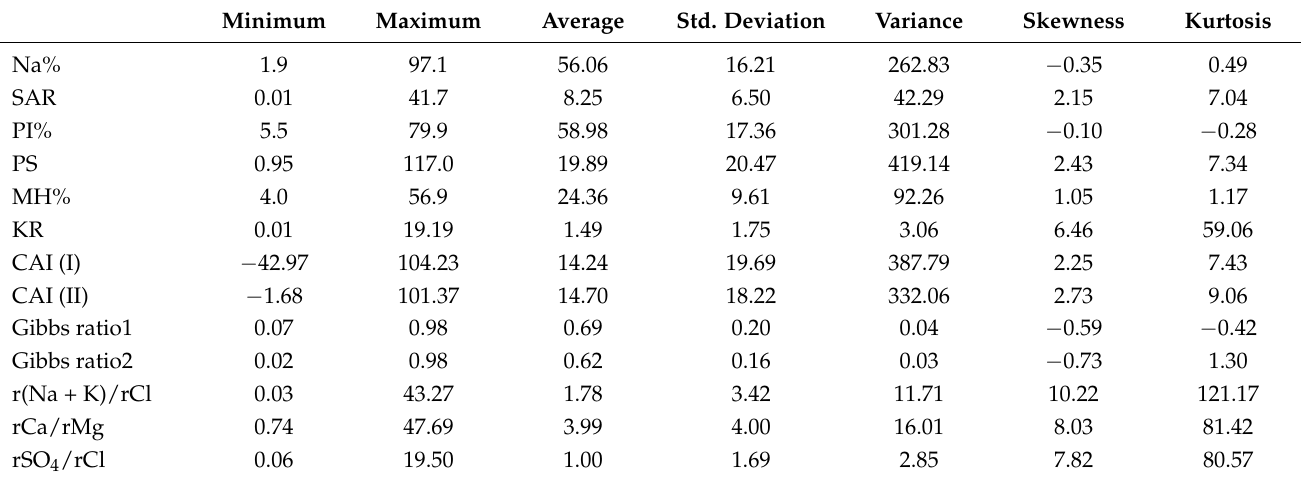
Table 2. Statistical analysis for all of the water quality indicators.